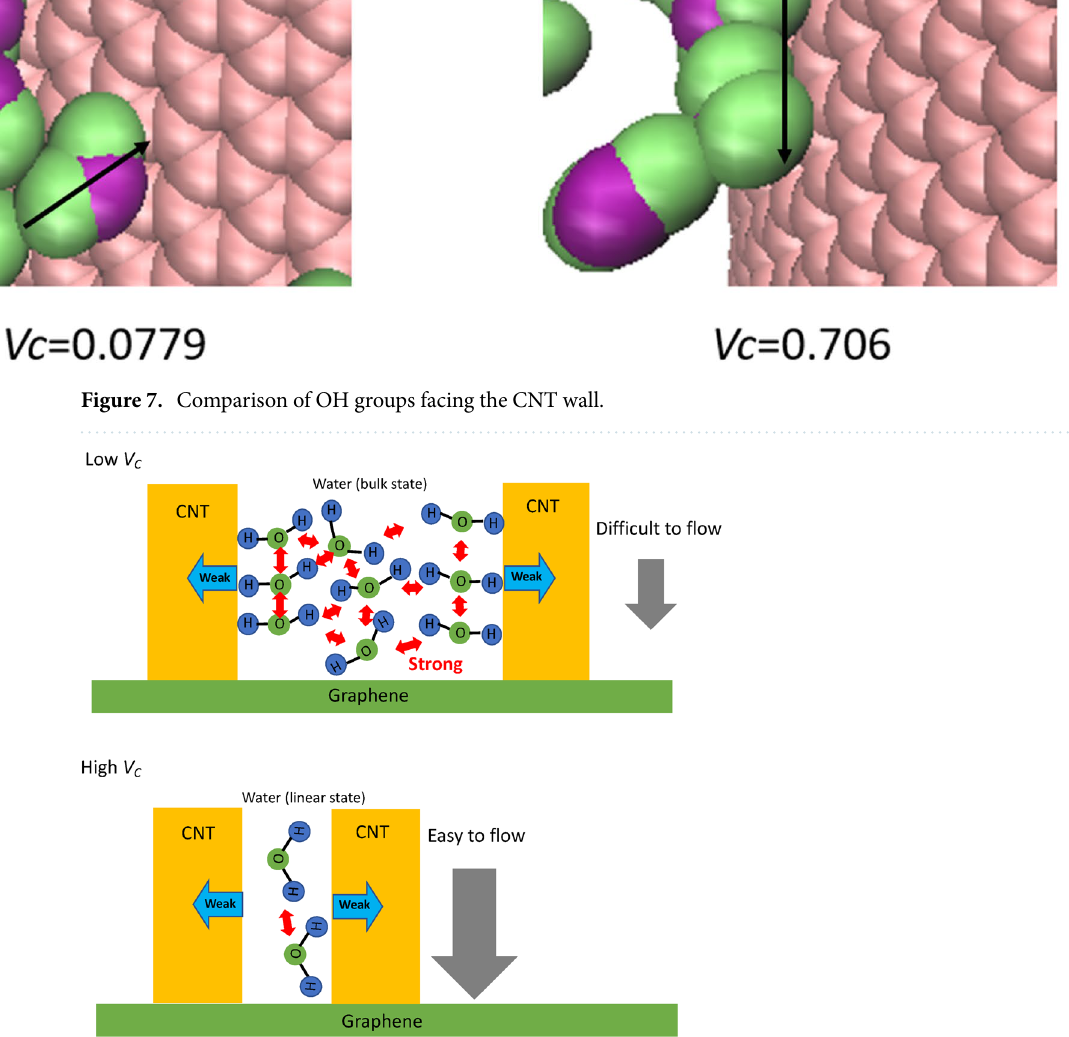
Figure 8. Mechanism of increase in water permeability in the interspace of CNTs in high V C